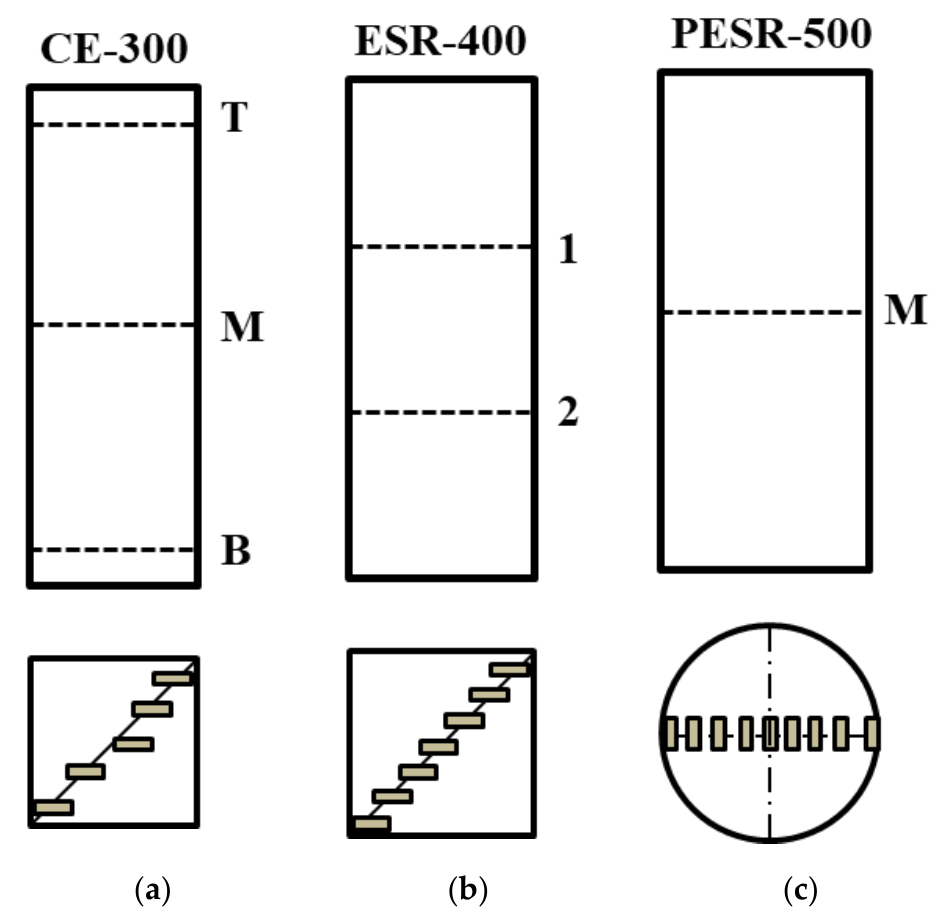
Figure 1. Schematic illustration of horizontal slices and sample positions on the consumable electrode ( a ) CE-300, ( b ) ESR, and ( c ) PESR remelted ingots.